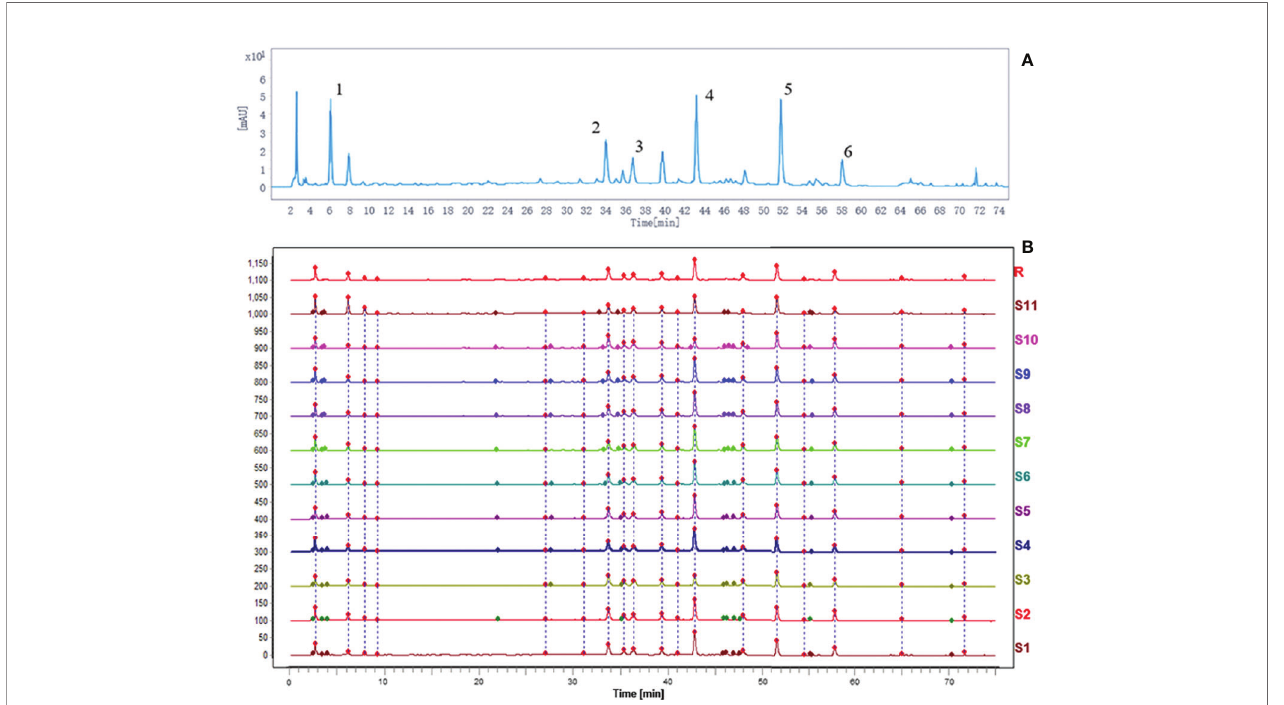
FIGURE 2 | HPLC fi ngerprint analysis of DHG. The HPLC chromatographic of DHG (A) . Comparability results of reproducibility of DHG samples (B) . The main components of DHG in the chromatograms are as follows: (1) gallic acid, (2) polydatin, (3) isoquercetin, (4) hesperidin, (5) salvianolic acid B, and (6) emodin-8-O- b -D- glucoside. HPLC, high-performance liquid